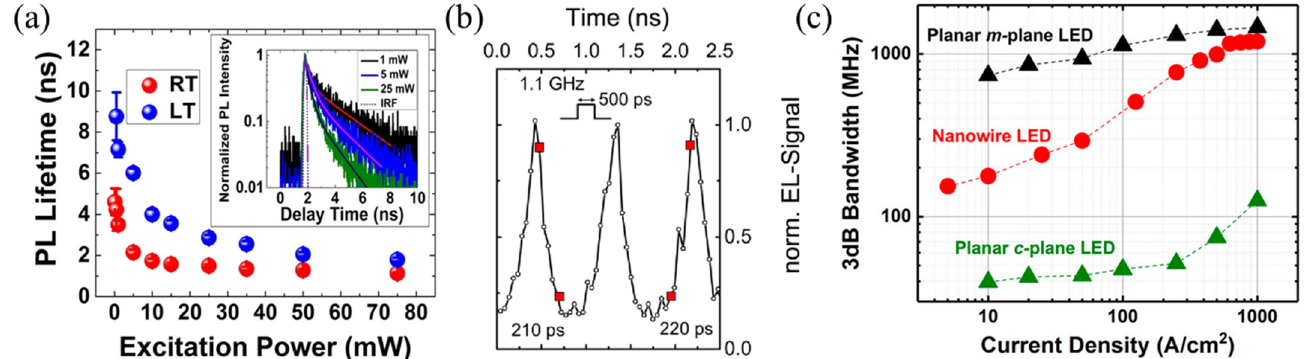
Figure 8. ( a ) PL lifetimes versus excitation power at room temperature (red, RT) and low temperature (blue, LT) from InGaN/GaN core–shell microrods. The inset shows the time-resolved PL decay curves for different excitation powers. Reprinted with permission from Ref. [14]. Copyright 2018, Nami et al. ( b ) Time-resolved EL signal of a microrod LED on Si(111). The devices were excited with a voltage pulse of 500 ps in width and a frequency of 1.1 GHz. Reprinted with permission from Ref. [6]. Copyright 2019 American Chemical Society. ( c ) The − 3 dB modulation bandwidth versus current density for a microrod LED (red), a planar polar LED (green), and a planar nonpolar LED (black). Reprinted with permission from Ref. [1]. Copyright 2019 American Chemical Society.